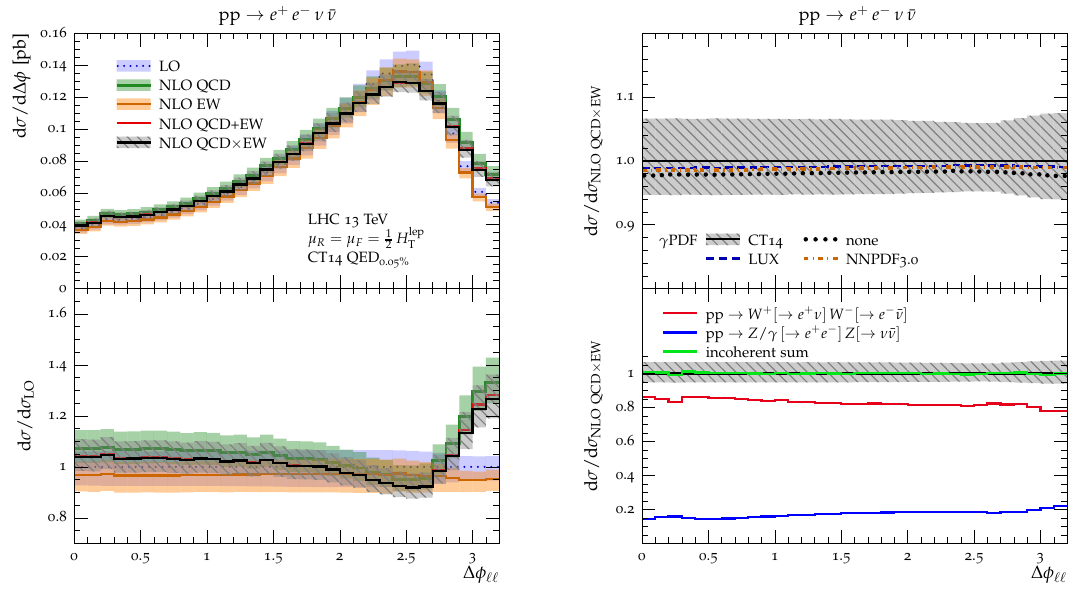
+ e (cid:0) (cid:23) (cid:22) (cid:23) at ‘‘ , for pp ! e